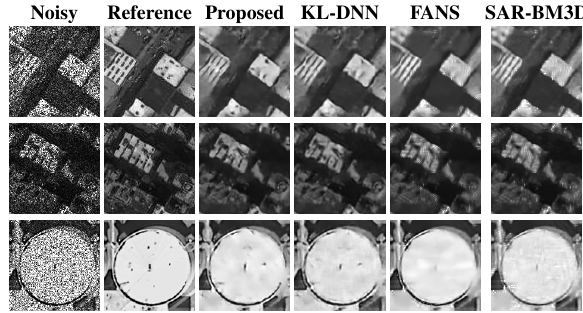
Figure 3. Results on simulated data, from top to bottom: clip1 (scraped Google Maps), clip2 (scraped Google Maps), clip3 (Mercedes Land Use)